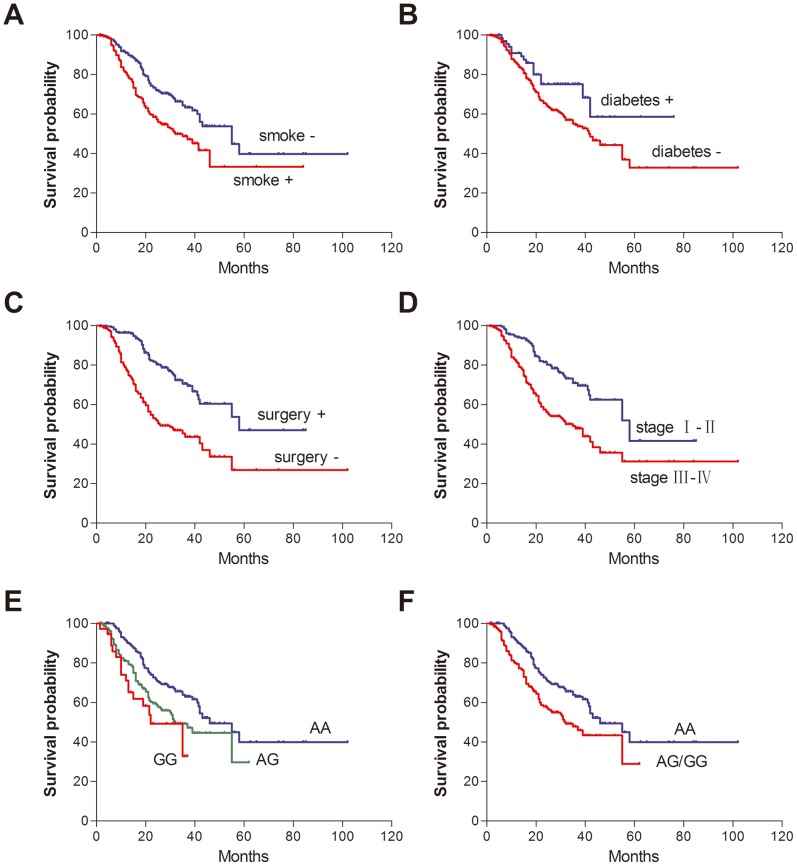
Kaplan-Meier plots of overall survival by clinical parameters, treatment status and pre-miR-27a rs895819 genotypes.Log-rank P values were (A) <0.001, (B) 0.034, (C) <0.001, (D) <0.001, (E) <0.001 and (F) <0.001, respectively.